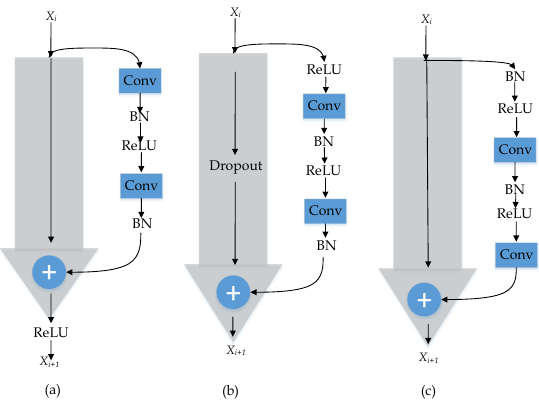
Figure 3. ( a ) Original residual unit with clear short-cut connection. ( b ) rectified linear unit (ReLU)-only pre-activation with dropout short-cut connection. ( c ) Full pre-activation with clear short-cut